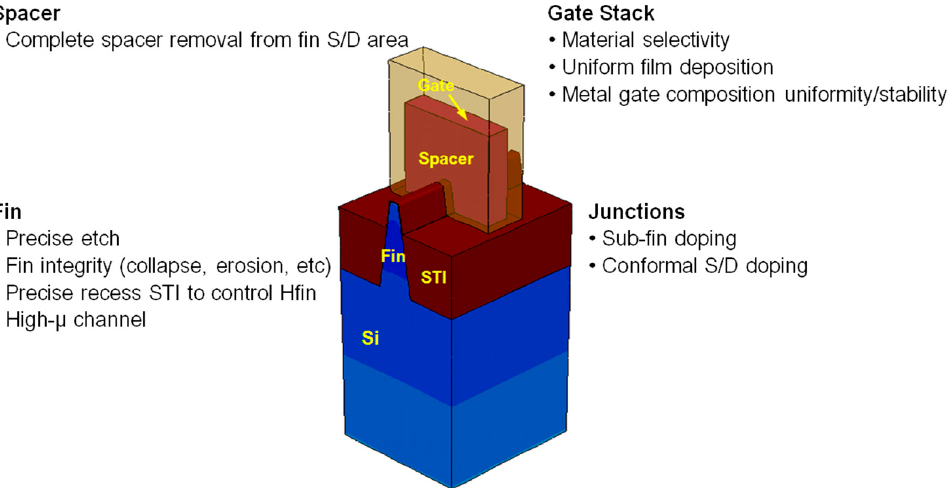
Figure 8. New challenges in the miniaturization of FinFETs [36].